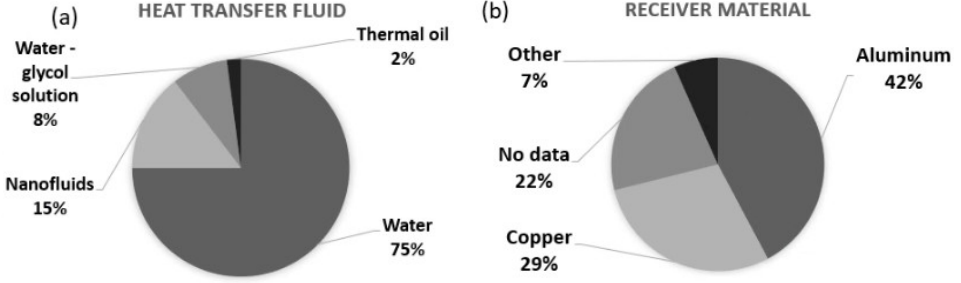
Figure 36. Pie chart showing the share of ( a ) HTF and ( b ) receiver material among papers regarding heat extraction devices with macroscale channels.